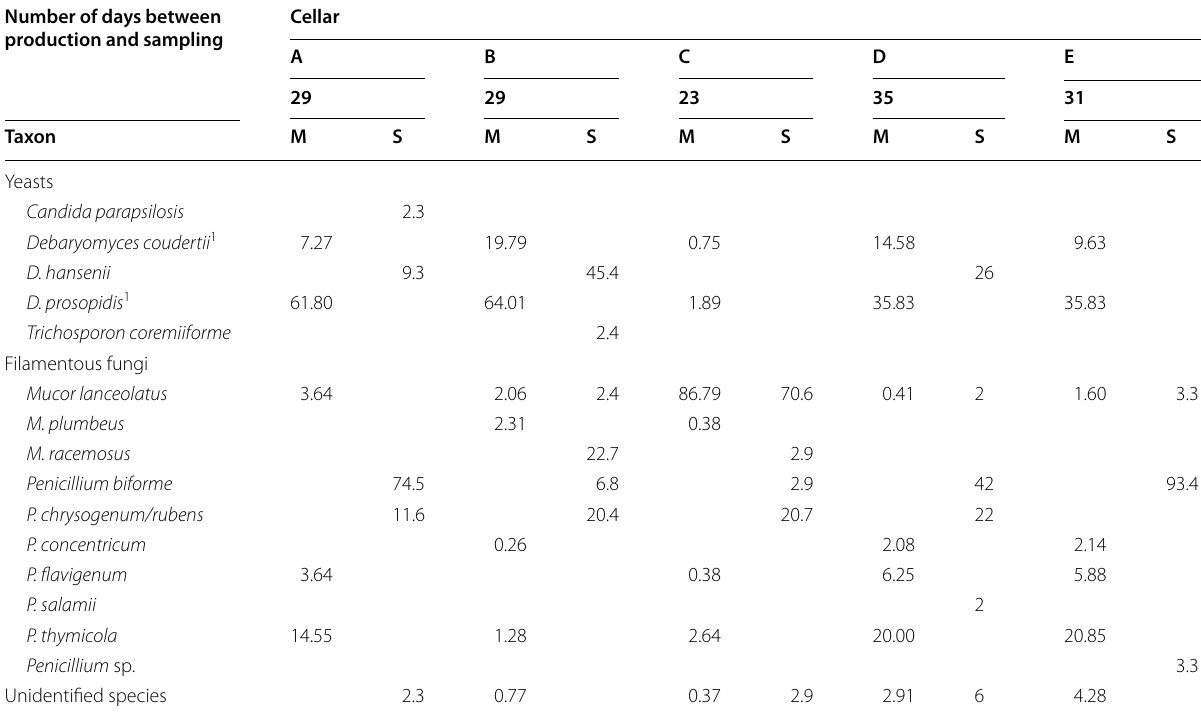
Values are expressed as percentages of the total number of isolates or reads, respectively. M: metabarcoding; S: serial dilution. A: Bolla and Carassina; B: Bresciana; C: Campo la Torba; D: Formazzora; E: Pontino. Database used for the metabarcoding identification: UNITE. 1 Debaryomyces coudertii and D. prosopidis have been identified by ITS, but ITS cannot distinguish them from D. hansenii (Martorell et al. 2005; Nguyen et al. 2009). D. hansenii has been identified by sequencing and MALDI- TOF MS